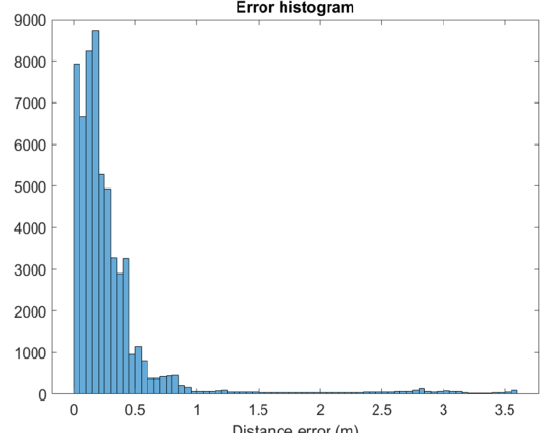
Figure 9. Histogram that represents the distances between the ground truth and the alignment obtained with the proposed method. Table 3. Average and median errors for the positioning of the